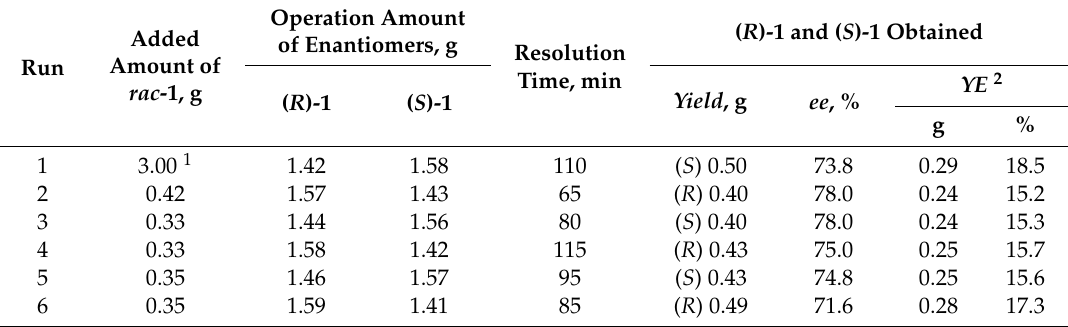
Table 4. Resolution by entrainment of rac -3-(3.4-dimethylphenoxy)propane-1,2-diol, rac - 1 in methyl tert -butyl ether (60 ml, 75 mg of crystal seeds on every run; crystallization temperature 27 °C).